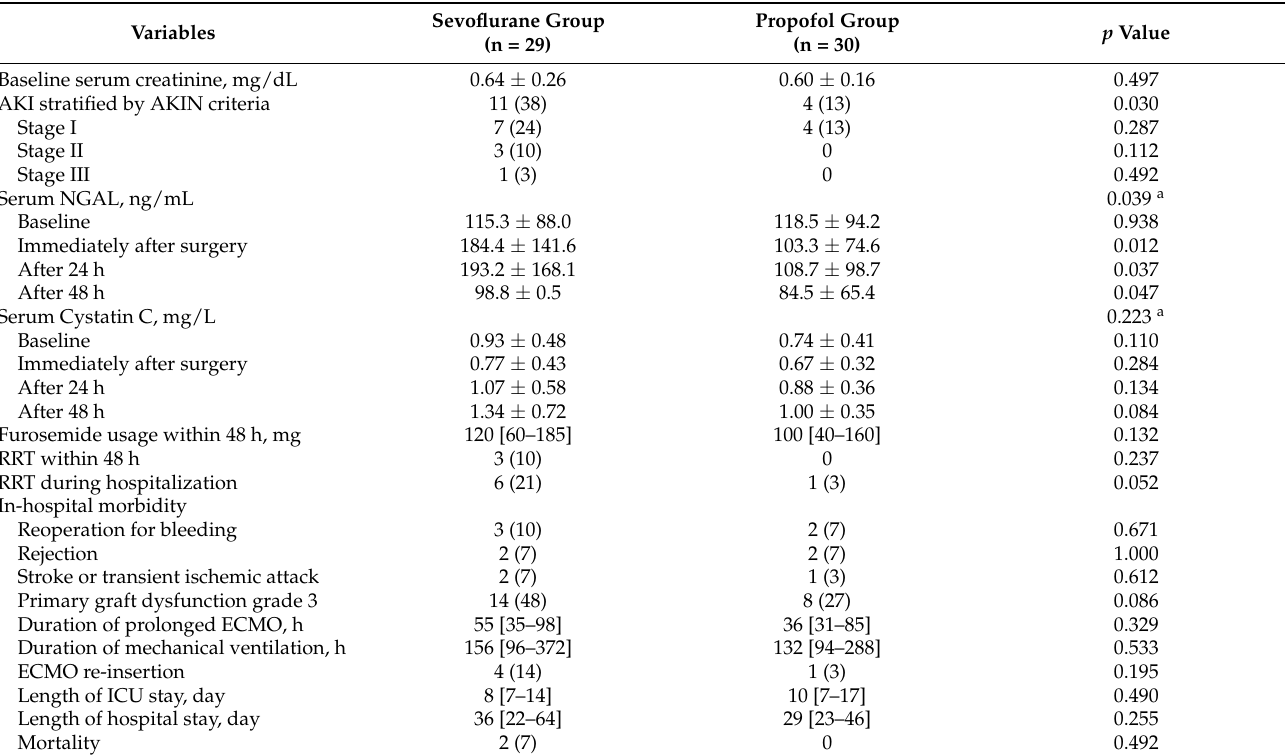
Table 3. Perioperative renal function and post-operative 30-day morbidity.